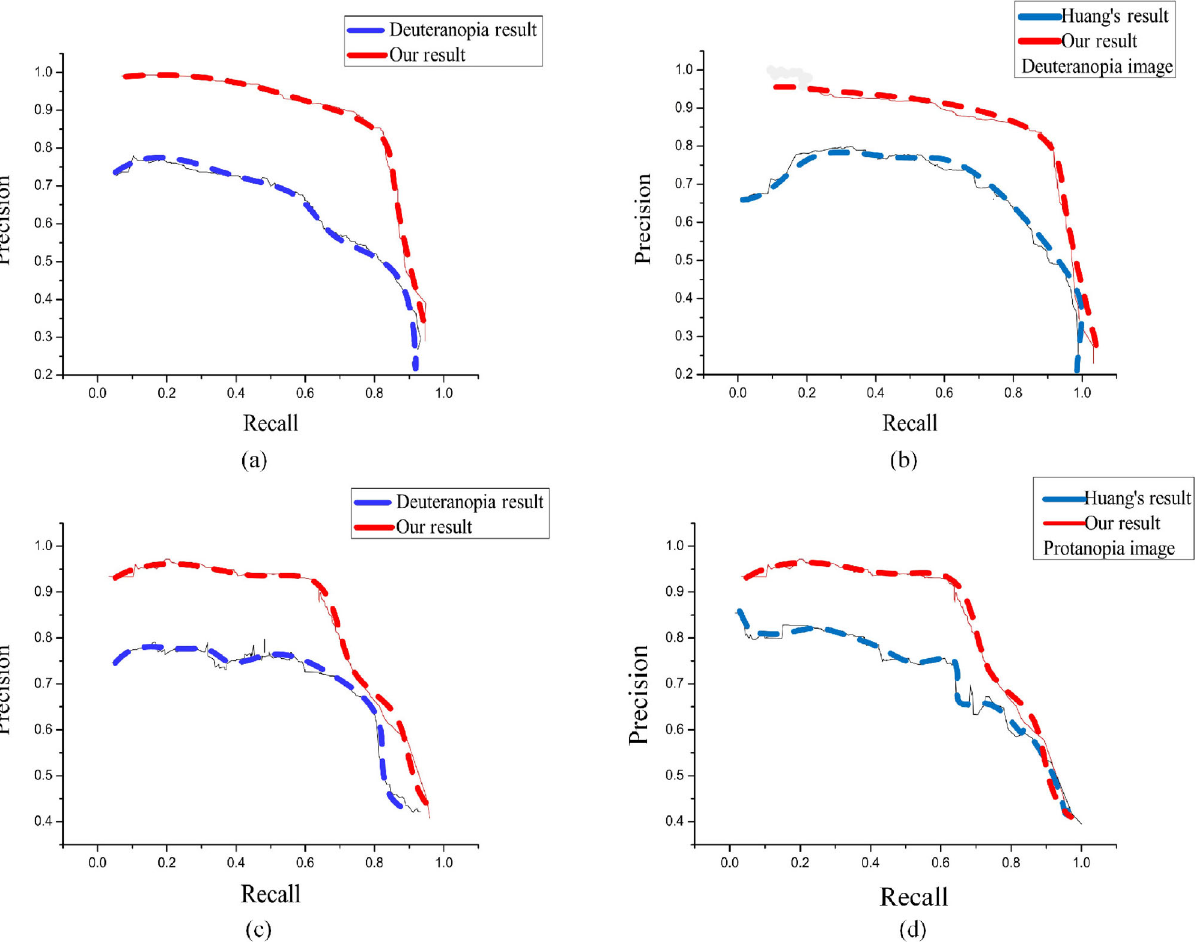
with the Huang’s color correction algorithm. It is clear that for a given recall rate, our method is more accurate than direct detection of colorblind images, and than Huang’s